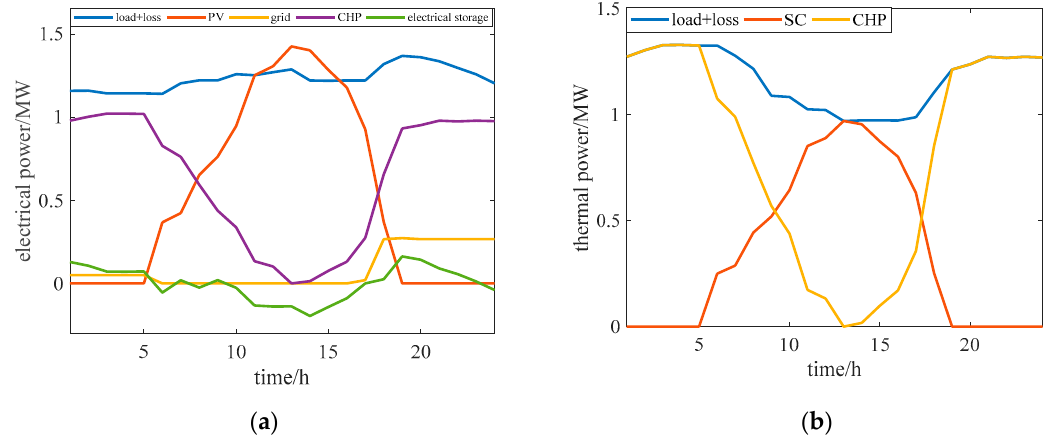
Figure 8. ( a ) Electrical power output in Case 2.3; ( b ) thermal power output in Case 2.3.